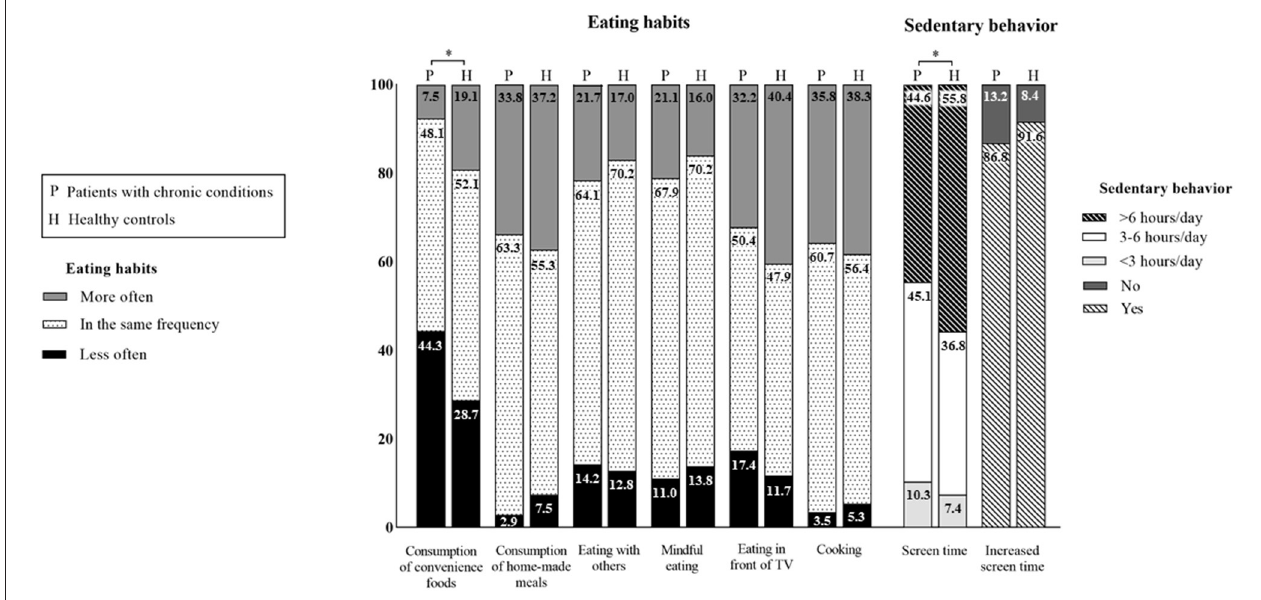
FIGURE 1 | Changes in eating habits and sedentary behavior among adolescents with chronic conditions ( n = 347) and healthy controls ( n = 95) during the COVID-19 pandemic. *Significant difference between groups ( p <